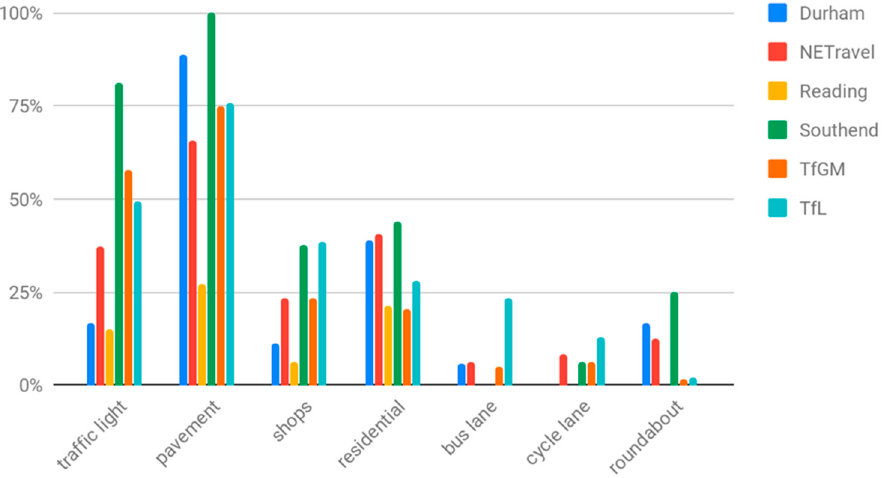
Figure 2. Percentage of cameras, for each source of open traffic camera images, that include the given scene element category within their frame of view.